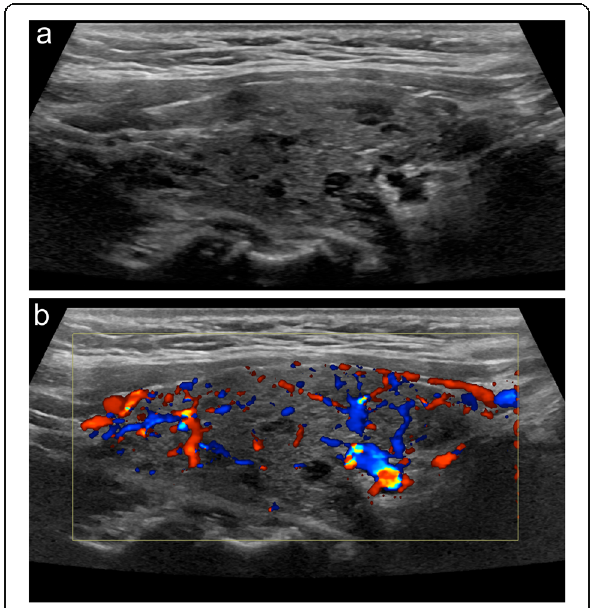
Fig. 21 Hashimoto ’ s thyroiditis. Grayscale ( a ) ultrasound imaging demonstrating diffuse enlargement of the thyroid gland with heterogeneous parenchyma and micronodular echotexture. Color Doppler ( b ) ultrasound imaging demonstrates diffuse hypervascularity, reflecting the early phase of disease secondary to the hypertrophic action of thyroid-stimulating hormone (TSH)